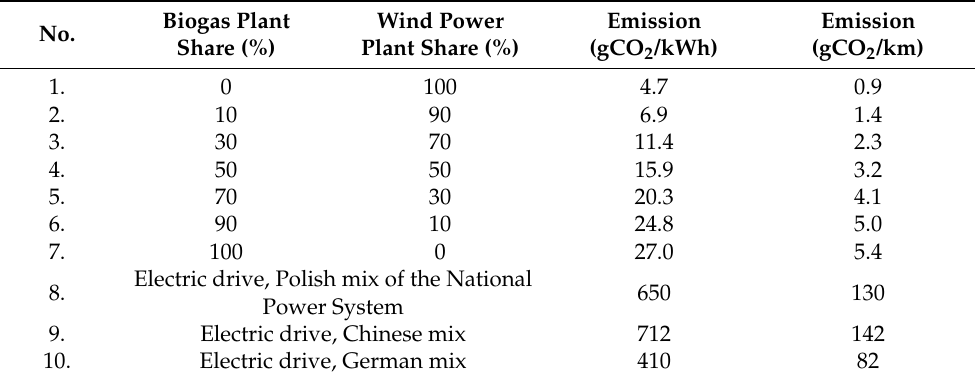
Table 6. Emissions of CO 2 for Nissan Leaf per kWh consumed and distance of one kilometre travelled supplied by